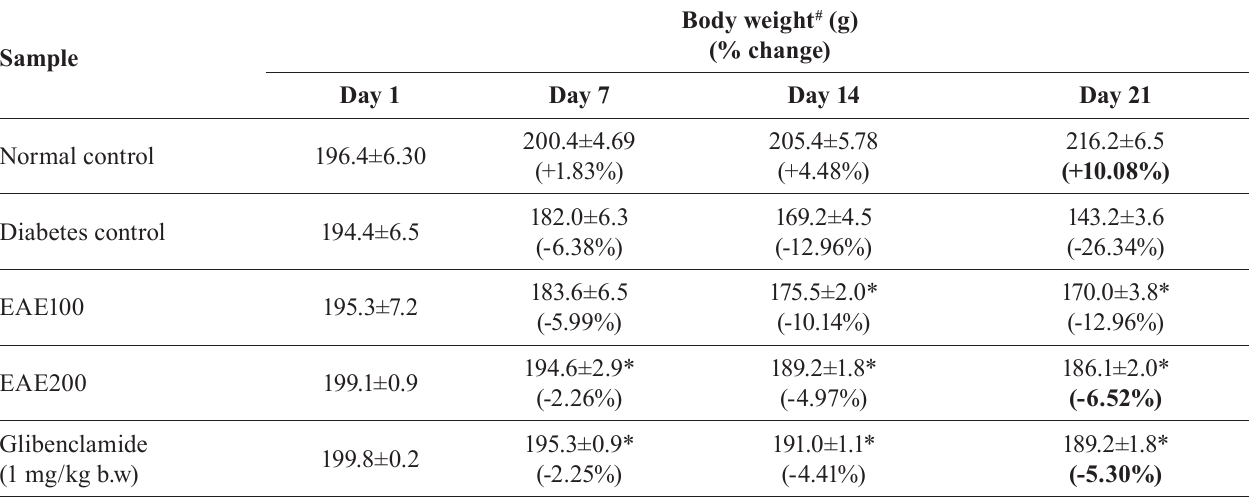
TABLE III – Effect of EAE on body weight in STZ-induced diabetic rats